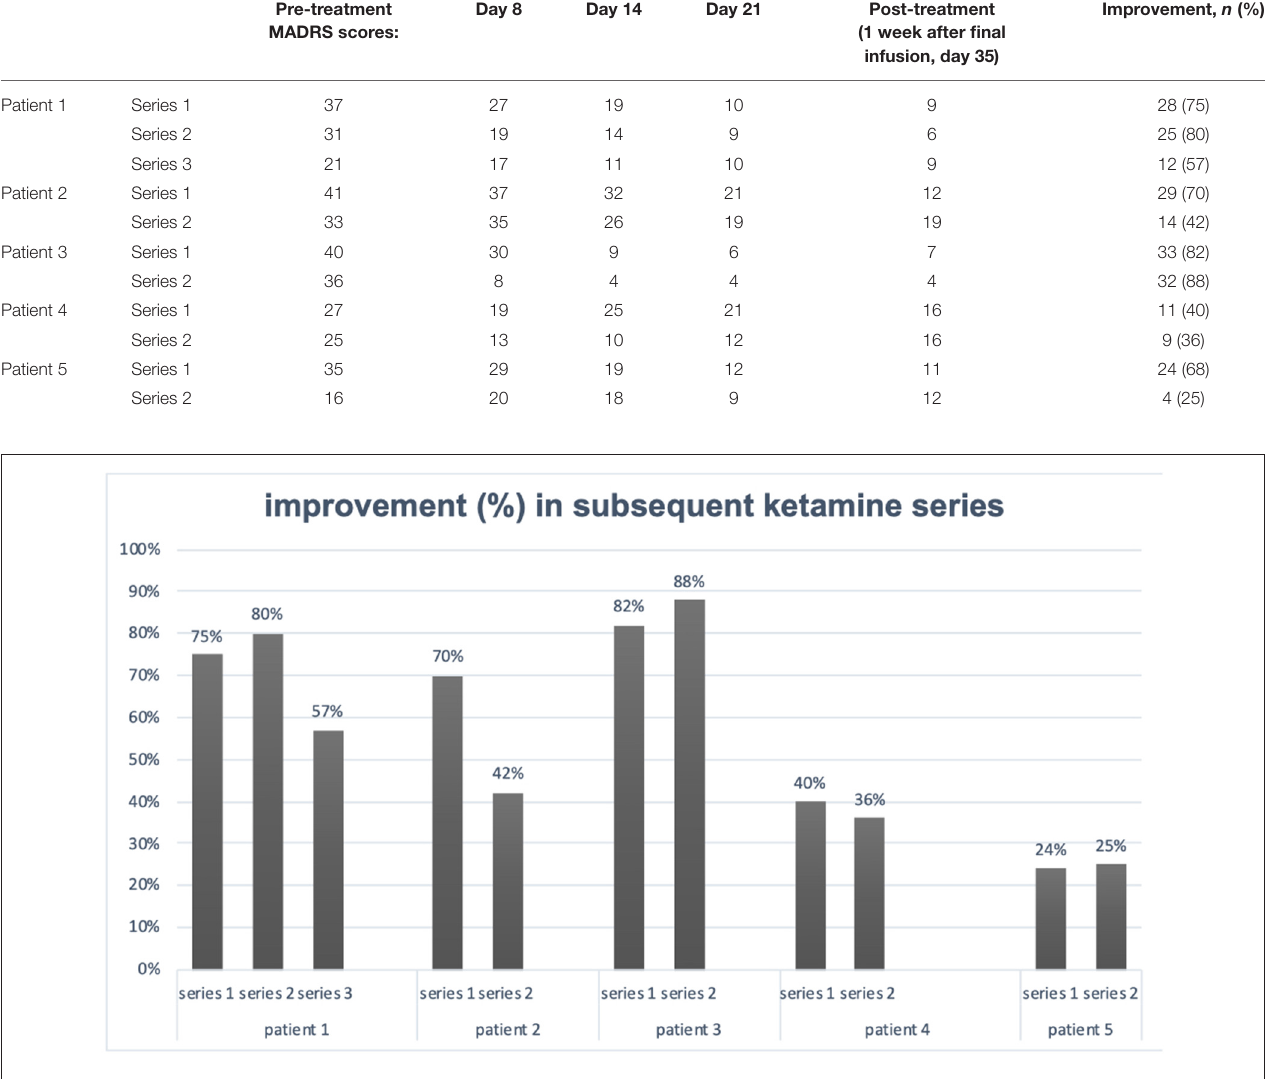
FIGURE 1 | Improvement in subsequent ketamine